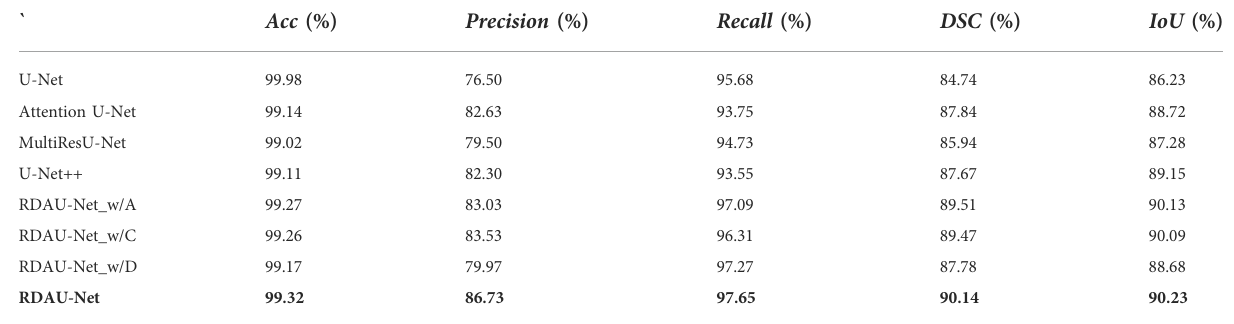
TABLE 2 Segmentation indicators for eight models on the test set.